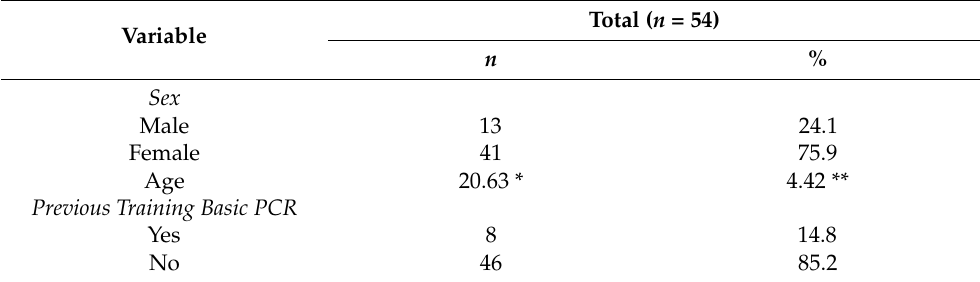
Table 2. Socio-demographic data of the participants ( n = 54).